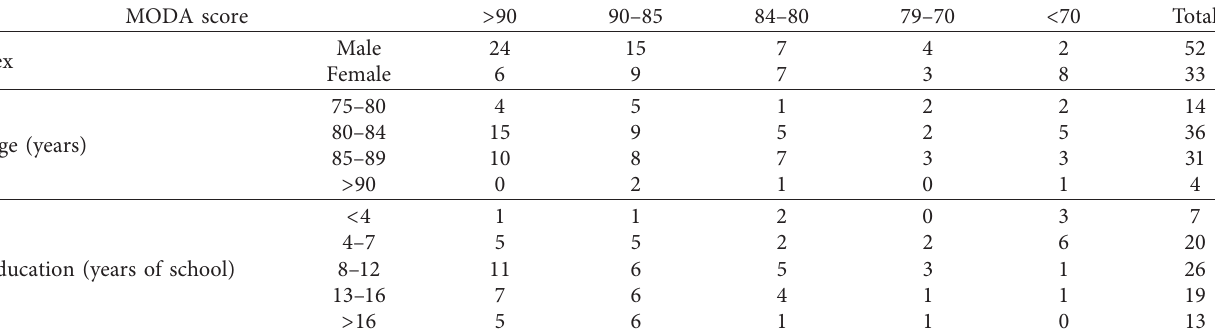
Table 3: MODA scores according to patients’